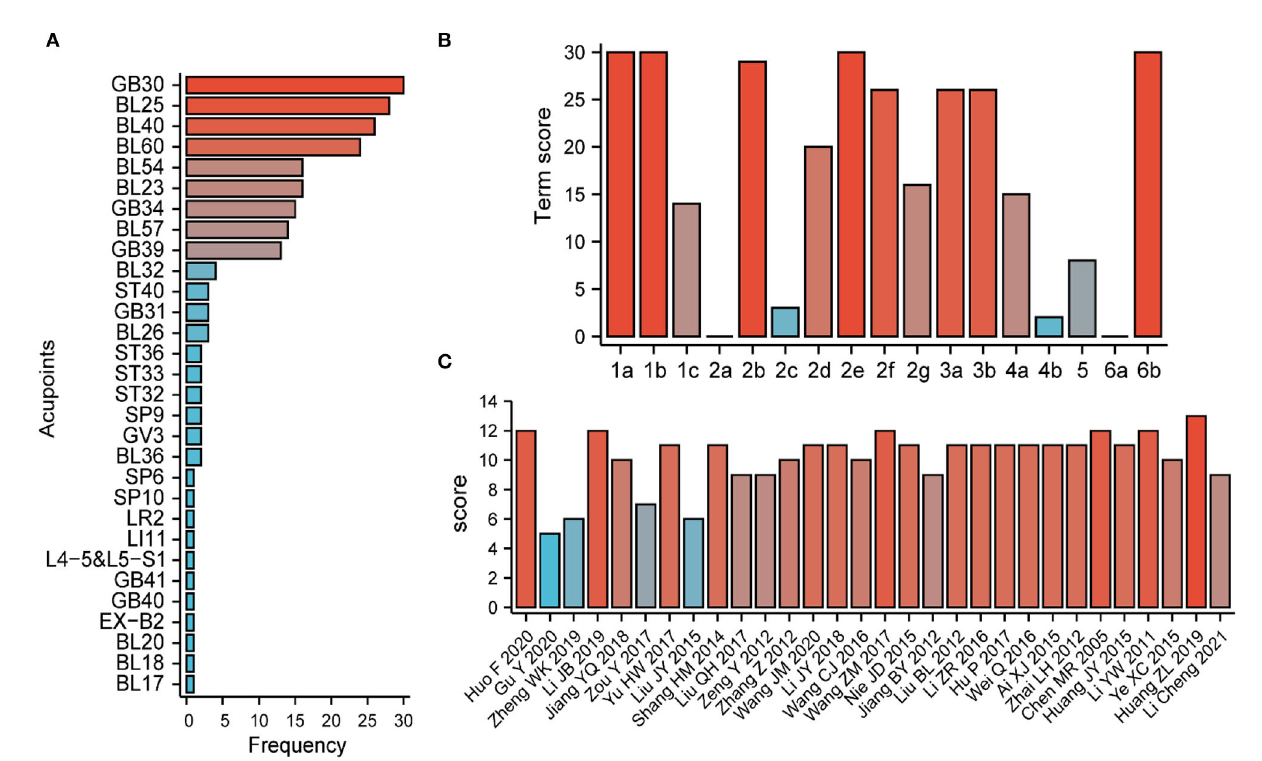
FIGURE3 Acupuncture details and Standards for Reporting Interventions in Clinical Trials of Acupuncture (STRICTA) checklist summary. (A) The frequency of acupoints in the included studies. (B) The total score for each STRICTA term. (C) The total STRICTA checklist score for each included study.